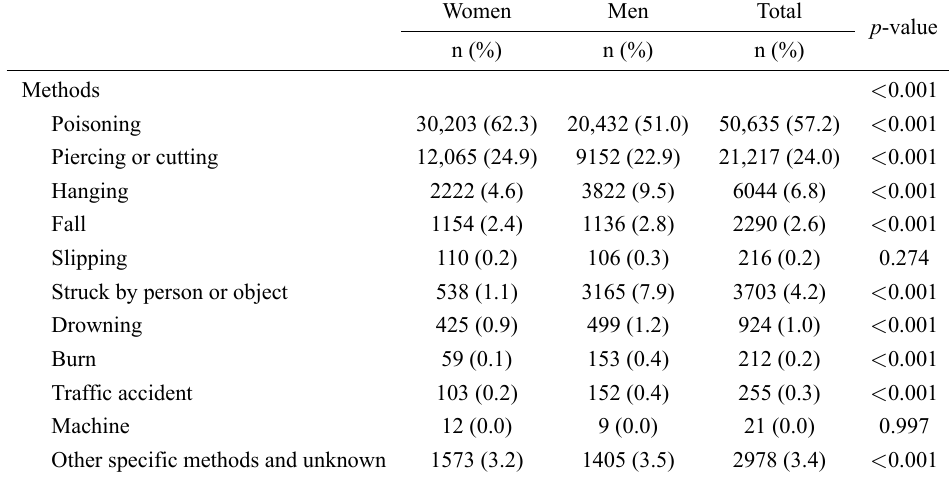
Table 3. Comparison of methods of suicide of men and women admitted to emergency departments after attempting